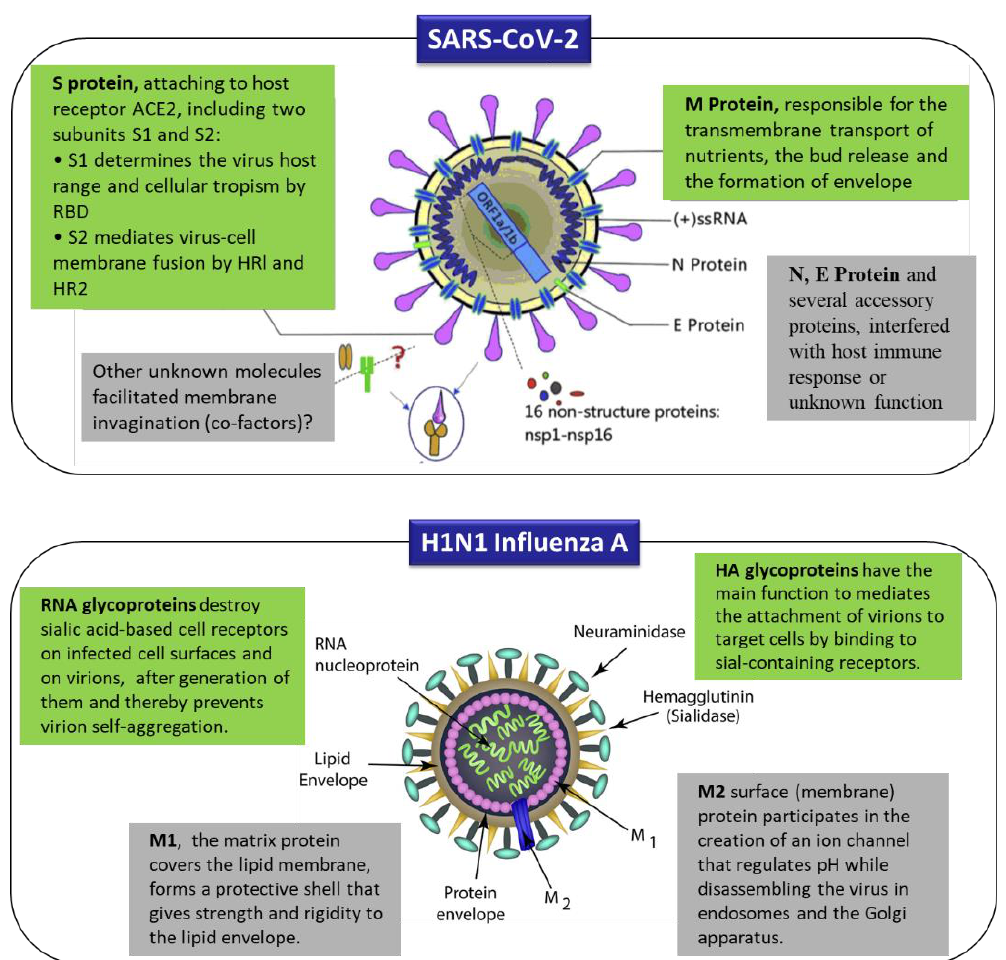
Figure 3. Schematic diagrams of the structural proteins components of SARS-CoV-2 (top), including spike (S) glycoprotein, small envelope (E), matrix (M) protein, and nucleocapsid (N) protein, as well as several accessory proteins [20] (licensed CC BY 4.0), and H1N1 influenza virus structure (bottom), including spikes made up of proteins, such as hemagglutinin (HA) and neuraminidase proteins (NA), matrix protein (M1), and ion channel or M2 protein. Adapted from Besednova et al. [70], licensed CC BY 4.0.